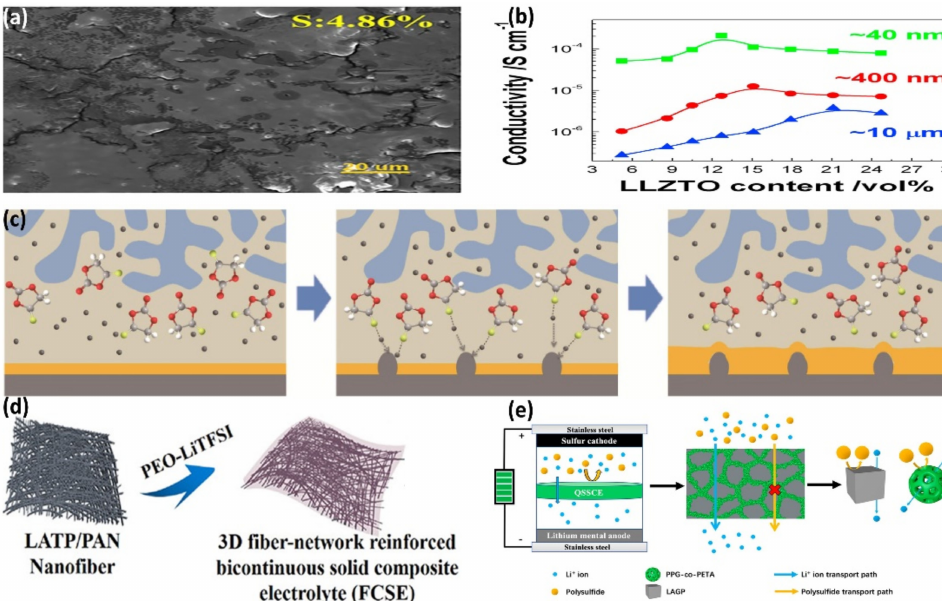
Figure 7. ( a ) SEM image of PEO − Pan − LLZO CPE 1C lithium anode after 500 cycles